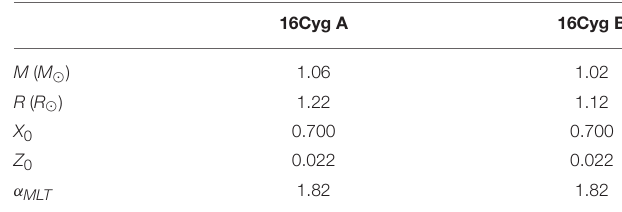
TABLE 5 | Parameters of the 16Cyg models with modified opacities and additional mixing used in this